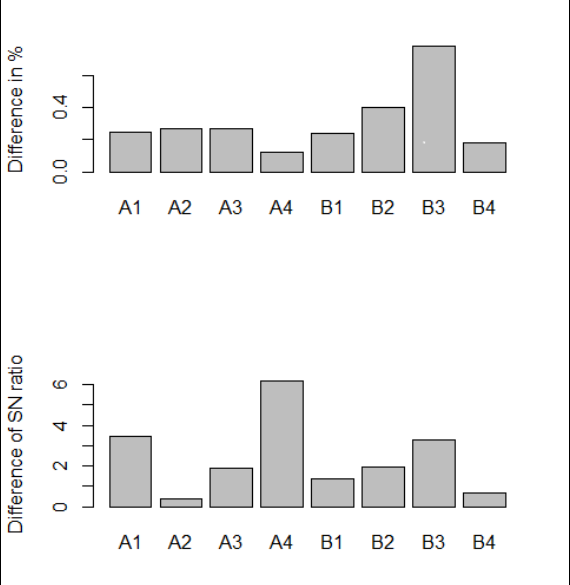
Figure 8. The effect of factors ’ levels on the variability (SPP).